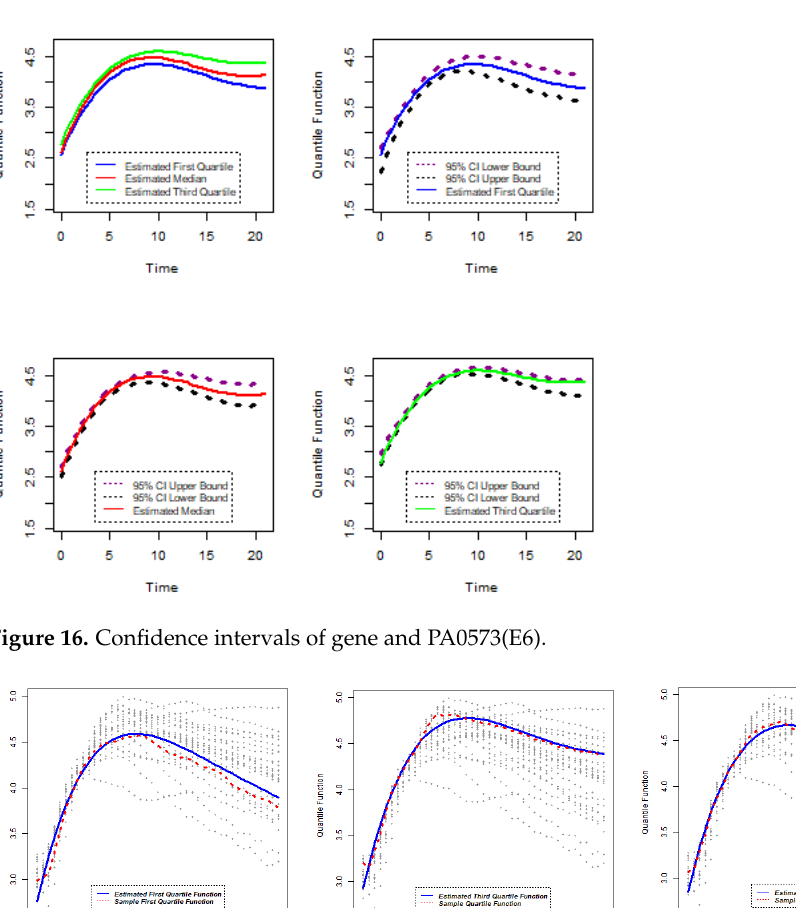
Figure 15. Confidence intervals of gene PA2975(rluc)(B3).